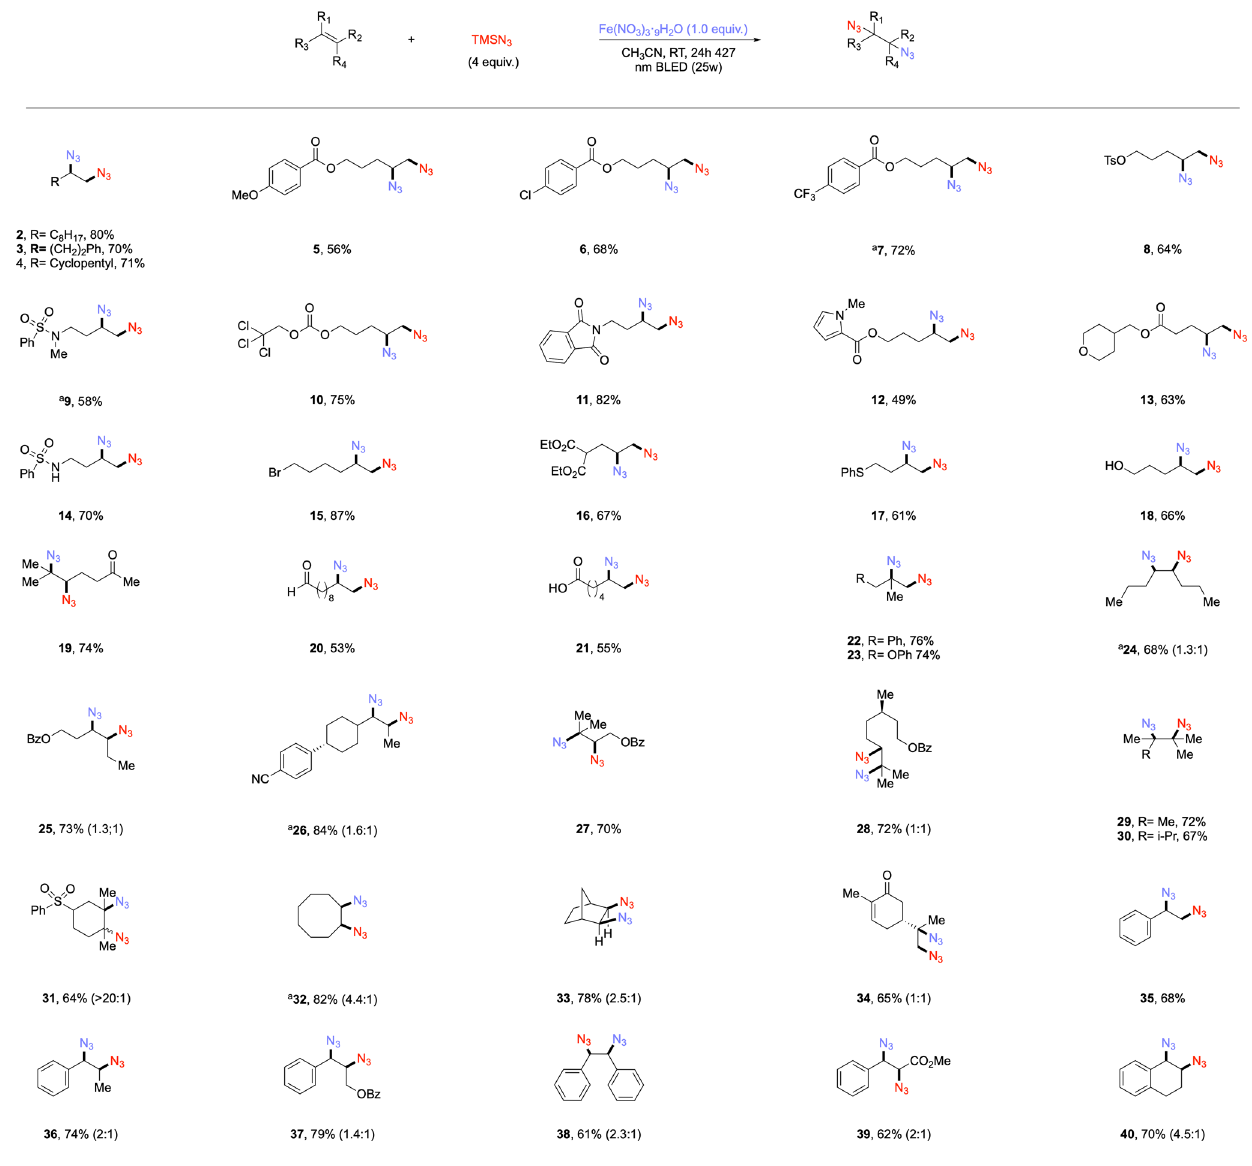
Fig. 2 | Scope of diazidationofalkenes(batch reaction). Reactionconditions:alkenes(0.1mmol,1 equiv.),TMSN 3 (4equiv.), Fe(NO 3 ) 3· 9H 2 O (1.0 equiv.),MeCN (0.1M), 24h, RT, N 2 , 427nm Kessil blue LED (25W). Ratios in the parentheses indicate the diastereomers proportion in corresponding